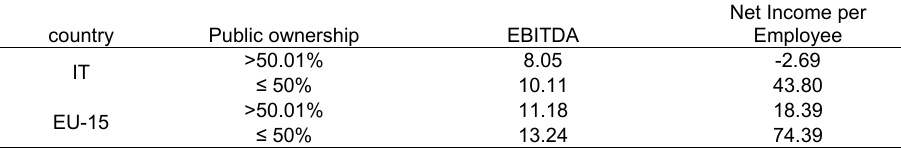
Table 7: Net Income per employee and EBITDA margin (Italy - EU